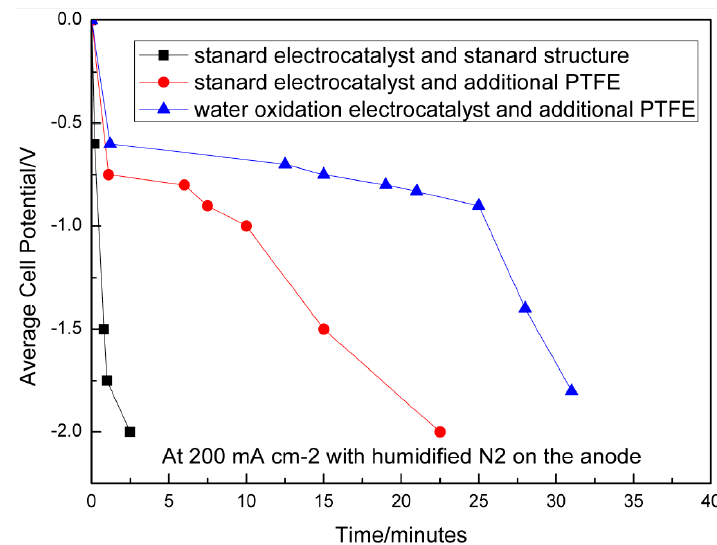
Figure 8. The effect of anode catalyst layer structure and composition in Ballard four-cell stack tests. Reproduced with permission from [16]. Copyright ECS, 2006. The anode contains 20 wt % Pt and 10 wt % Ru supported on Vulcan XC72R at an electrode loading rate of ca. 0.3 mg · Pt · cm − 2 with the water oxidation electrocatalyst added at a loading rate of ca. 0.1 mg · Ru · cm − 2